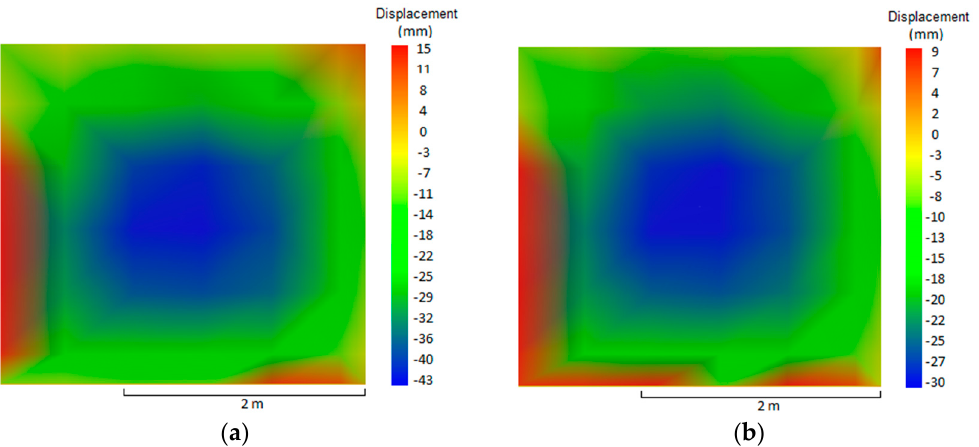
Figure 12. Displacement of the plane at ( a ) 30 min and ( b ) 240 min—W3.